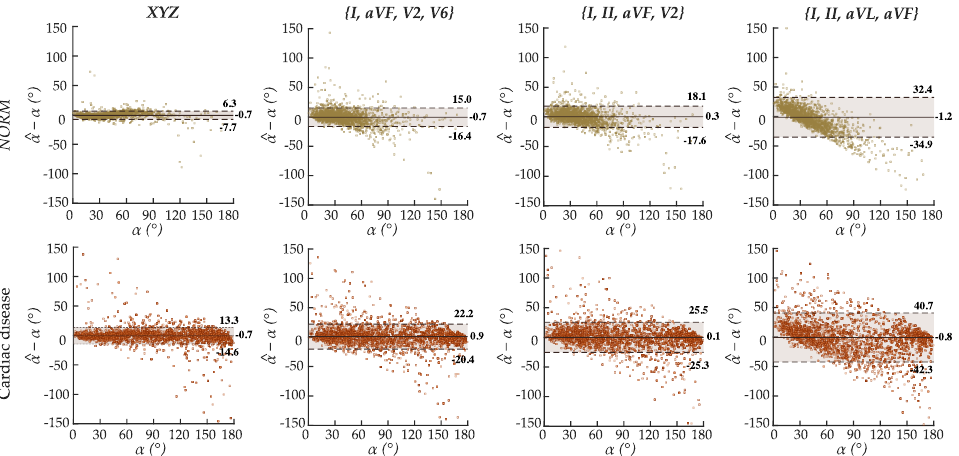
Figure 10. Bland-Altman diagrams of deep-learning-based estimation of (cid:98) α from various sets of leads of ECGs with ( top ) normal ( NORM ) and ( bottom ) diseased cardiac